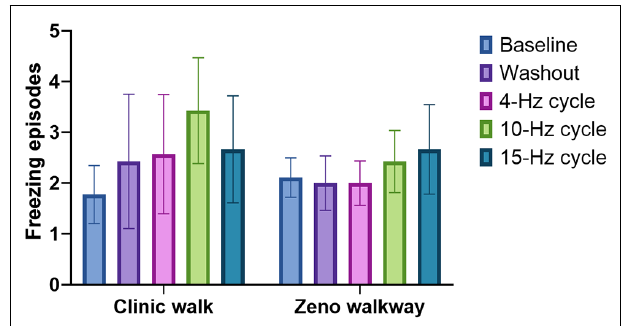
FIGURE 3 | The effect of BCDBS on freezing of gait (FOG): the number of freezing episodes during two different walking tasks are shown for all five test conditions. There were no significant differences among all five